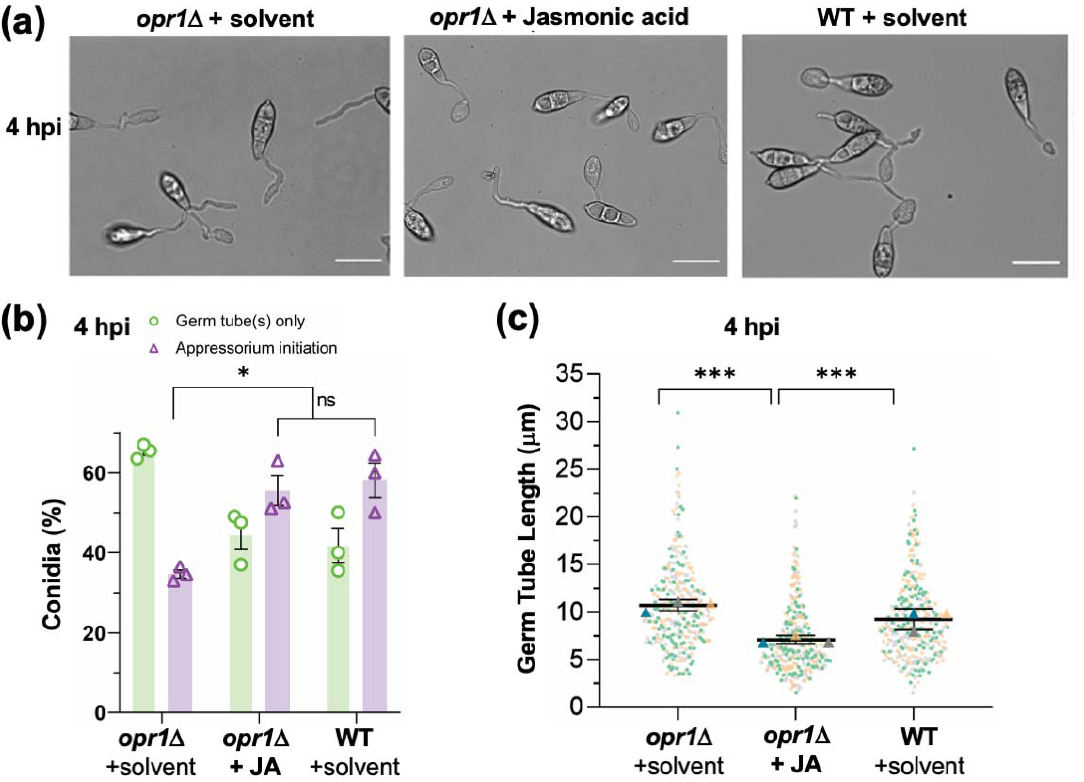
Figure 4. Loss of Opr1 significantly delays appressorium initiation in M. oryzae . ( a ) Exogenous JA corrects the delayed appressorium initiation defect in opr1 Δ . Bright-field micrographs of the developing appressoria in opr1 Δ and WT strain. Compared to the WT control, overall hooked structures (indicating the initiation of appressoria formation) in opr1 Δ germ tubes were significantly reduced; but are restored upon treatment with exogenous JA. Conidia were inoculated and grown on the inductive cover glass surface for 4 h. Scale bar 10 µ m. ( b ) Quantification of the chemical complementation experiment depicted in A. Data shown represents the mean ± SEM from three independent experiments, and two-tailed unpaired Student’s t -test determined p -values, * p < 0.05. n = 300 conidia per experiment ( c ) Dots and box plot depicting germ tube length in conidia that have initiated appressorium formation in opr1 Δ and WT strain of M. oryzae . Data ( n = 300) is derived from three independent experiments, with two-tailed t -test performed to evaluate the significance values, *** p < 0.001.